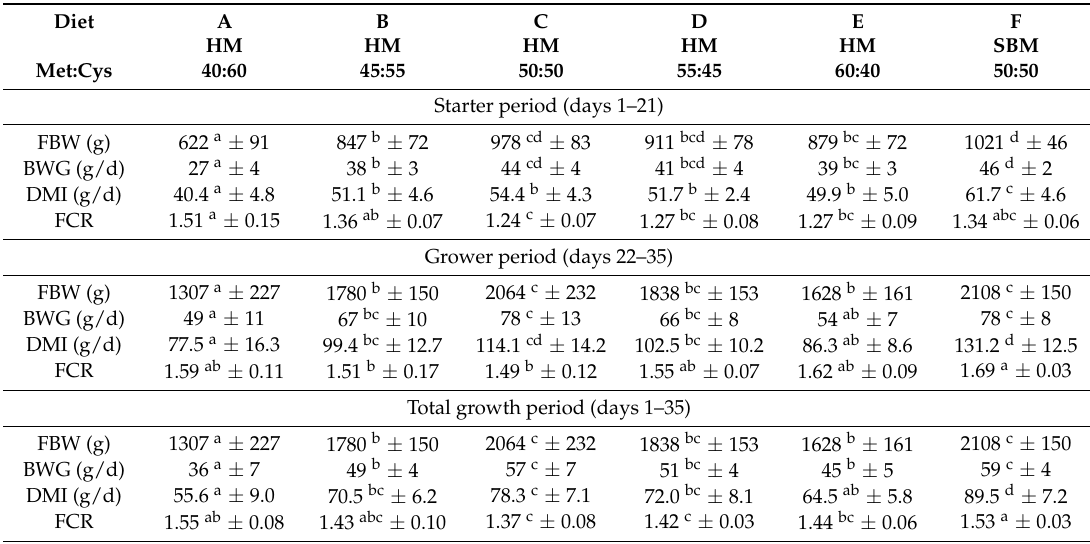
Table 4. Results of growth and feed efficiency parameters 1